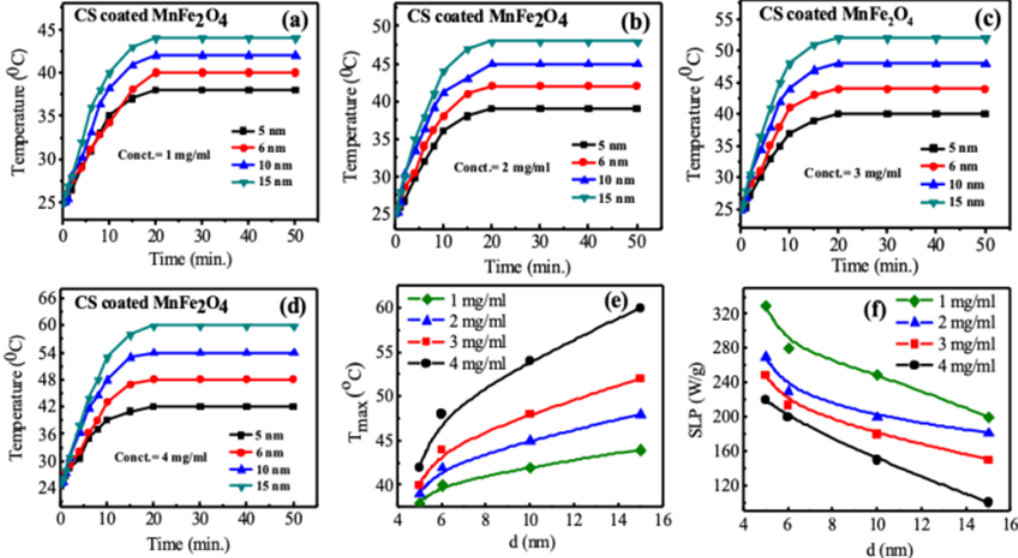
Figure 12. Time dependence temperature curves of CS-coated MnFe 2 O 4 nanoparticles with a RF magnetic field of an amplitude of 26 mT and a frequency of 342 kHz. The curve presents time dependence of temperature curves of ( a ) 1 mg/mL, ( b ) 2 mg/mL, ( c ) 3 mg/mL, ( d ) 4 mg/mL. Subsequently, nanoparticle size dependence of ( e ) maximum temperature (T max ), and ( f ) specific loss power (SLP) are presented.